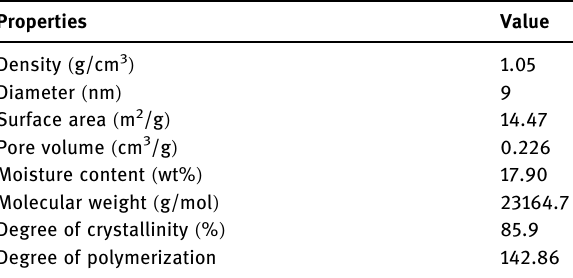
Table 1: Physical properties of SPCNC and their